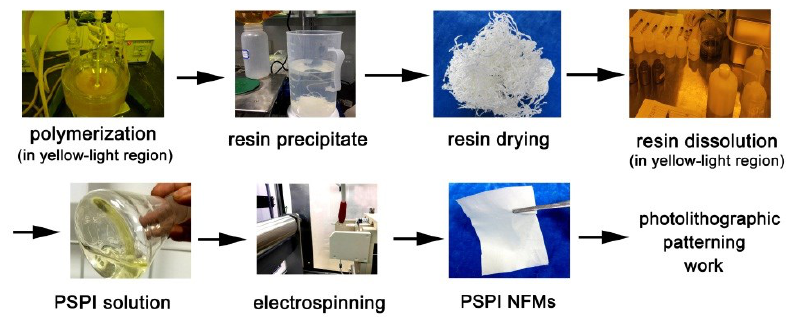
Figure 5. Electrospinning fabrication for the photosensitive PI and SPI NFMs.